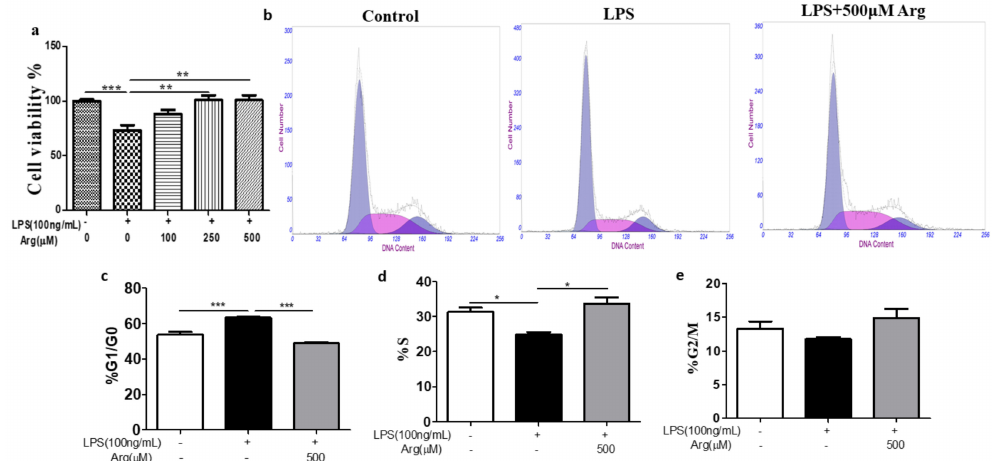
Figure 2. The e ff ect of L-arginine supplementation on LPS-induced cell cycle arrest and cell variability inhibition. ( a ) Cell viability of IPEC-J2 cells ( n = 8). ( b ) Cells after treatment were collected and stained with Propidium Iodide (PI) solution after fixation by 70% ethanol. Then the DNA content of cells was analyzed by flow cytometry. Representative histograms show regions corresponding to S, G0-G1 and G2-M phases of the cell cycle. Data are from four independent experiments. ( c )–( e ) are bar graph data showing that the percentages of S, G0-G1, and G2-M phases of the cell cycle under di ff erent treatment, respectively. Data were expressed as mean ± SEM. * p < 0.05, *** p <